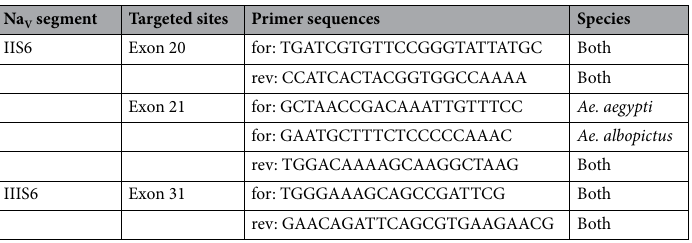
Table 4. Primers for HRM analyses in Aedes aegypti and Aedes albopictus . All primer sequences are in the 5 ′ -3 ′